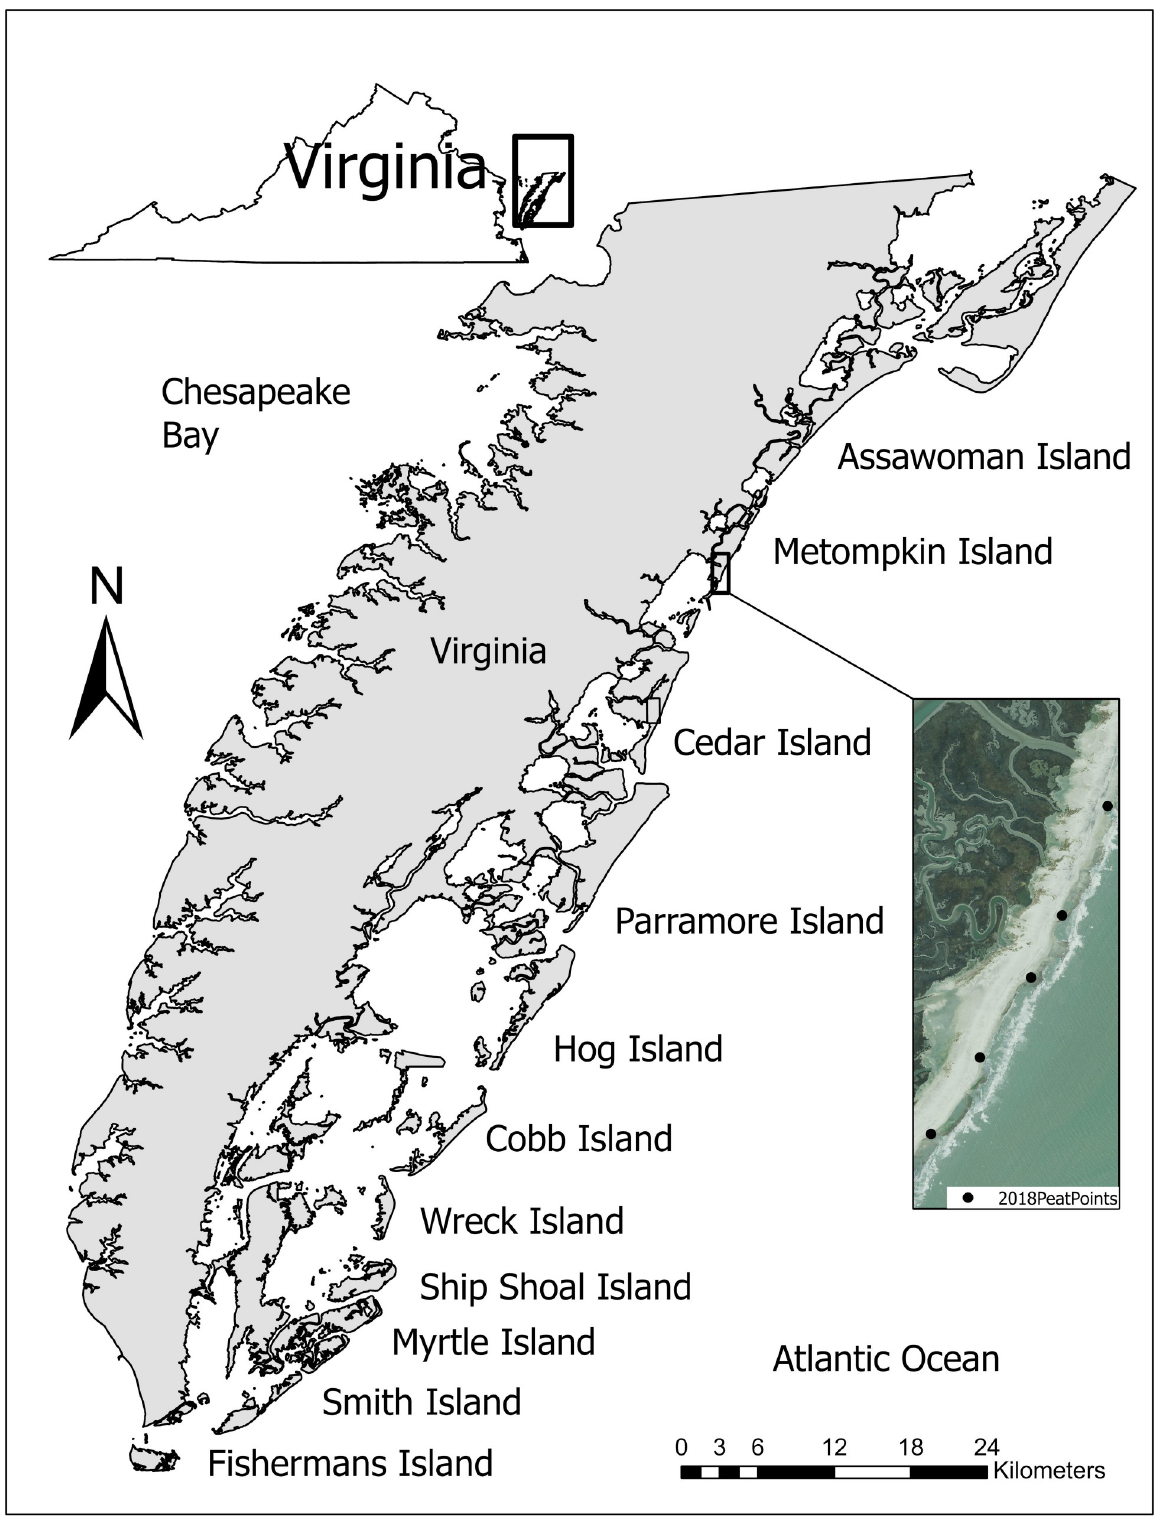
Fig 1. Study area on the Virginia Coast Reserve Long Term Ecological Research site consisting of barrier islands off the Eastern Shore of Virginia.